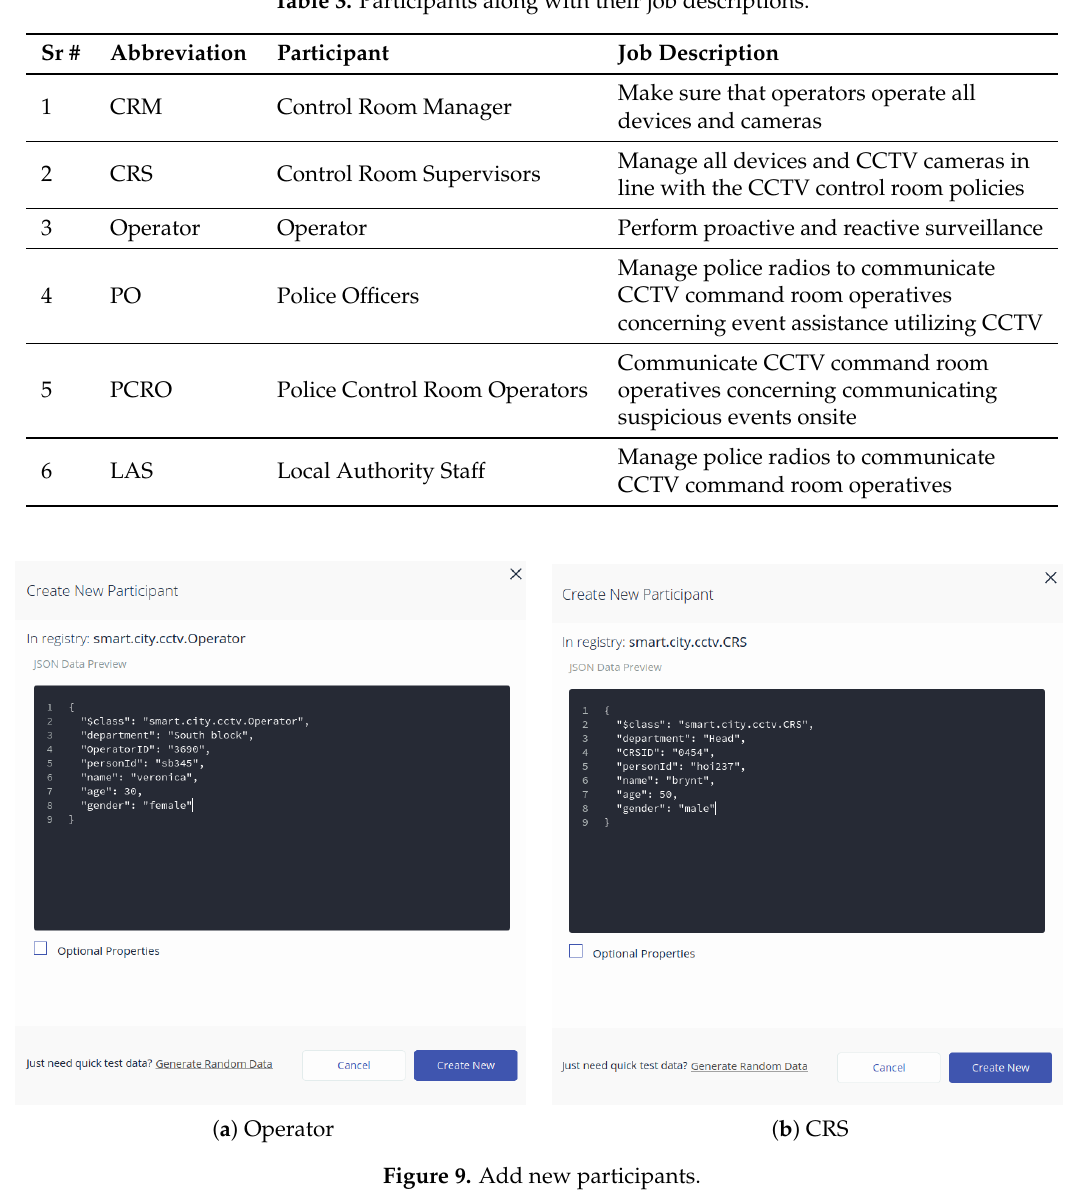
Table 3. Participants along with their job descriptions.